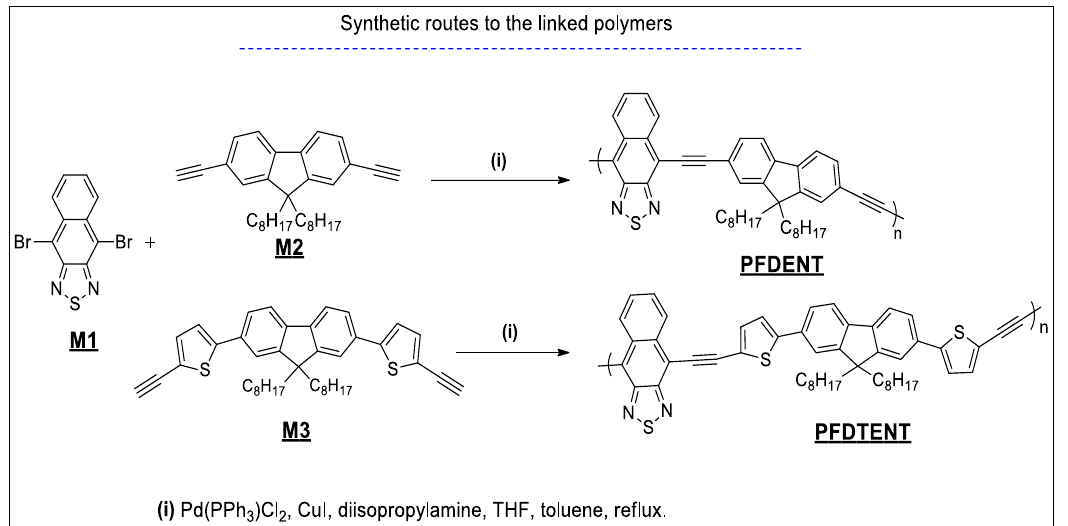
Table 1. GPC data of PFDENT and PFDTENT